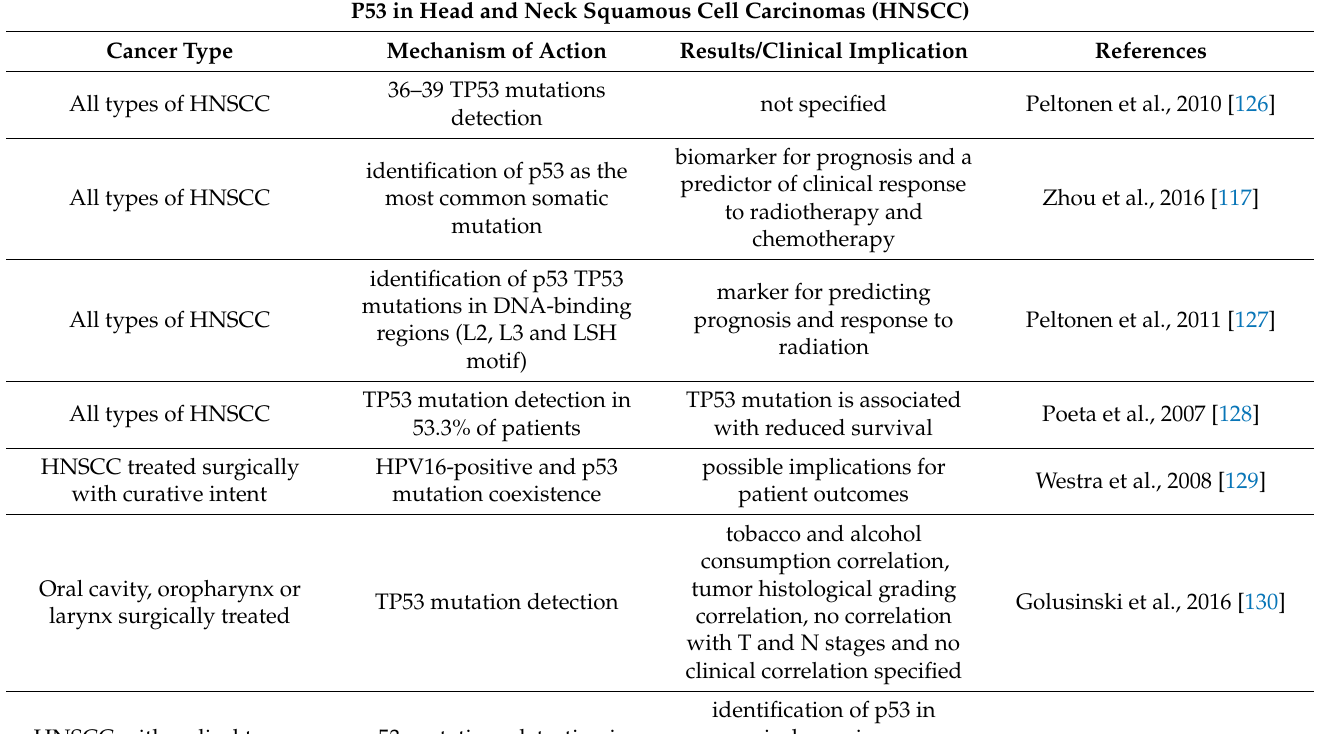
Table 1. Various roles of p53 in different anatomical sites of head and neck